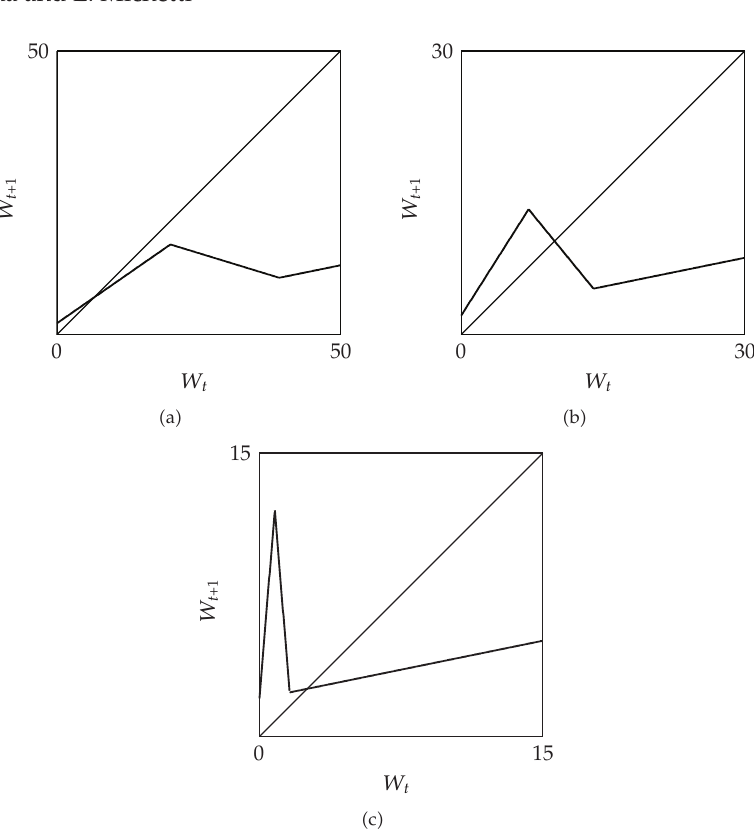
Figure 1: Scheme of f as defined in (cid:3) 2.14 (cid:4) in the three cases of localization of the fixed point: in (cid:3) a (cid:4) , μ (cid:7) 1 . 5, in (cid:3) b (cid:4) , μ (cid:7) 6, and in (cid:3) c (cid:4) , μ (cid:7) 60.